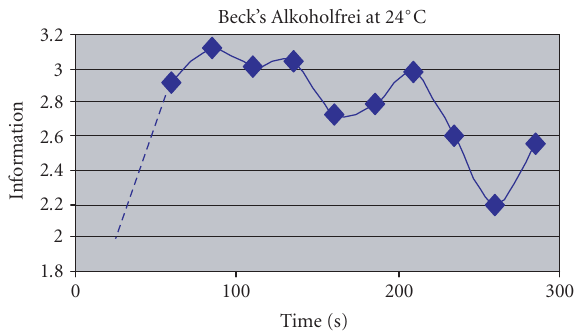
Figure 5.1. The Shannon information entropy of the bubble size distribution of Beck’s Alkoholfrei beer at 24 ◦ C as a function of